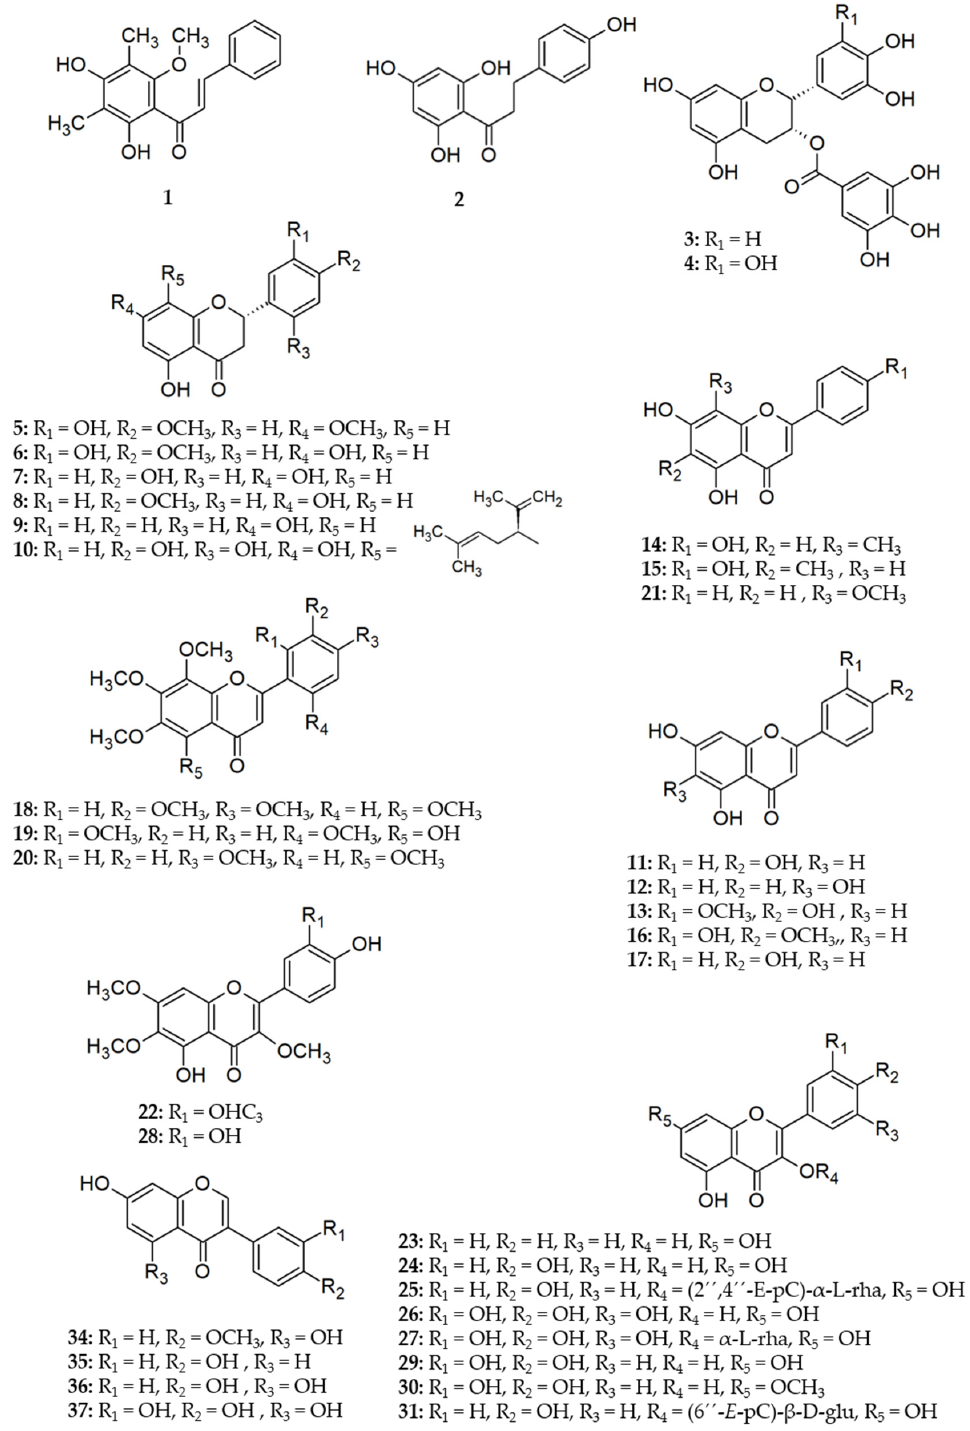
Figure 2. Structures of naturally occurring flavonoids reported as efflux pump inhibitors. Compounds of chalcone, flavan-3-ol, flavanone, flavone, flavonol and isoflavone subclass are shown here, for flavonolignans see Figure 3. E -pC = E -p- coumaroyl; α - L -rha = α - L -rhamnoside; β - D -glu = β - D -glucoside.